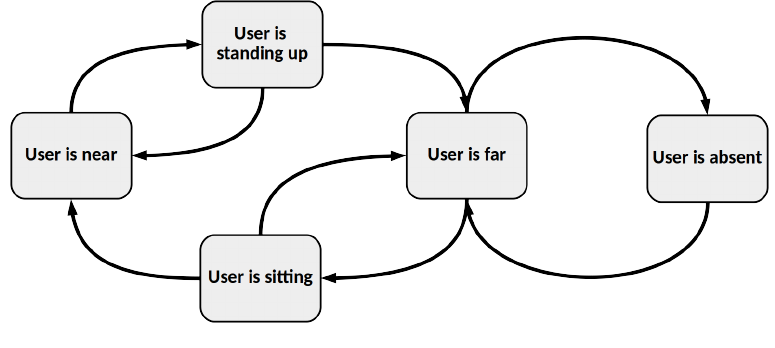
Figure 6. External state of the robot in relation with the position of user in the